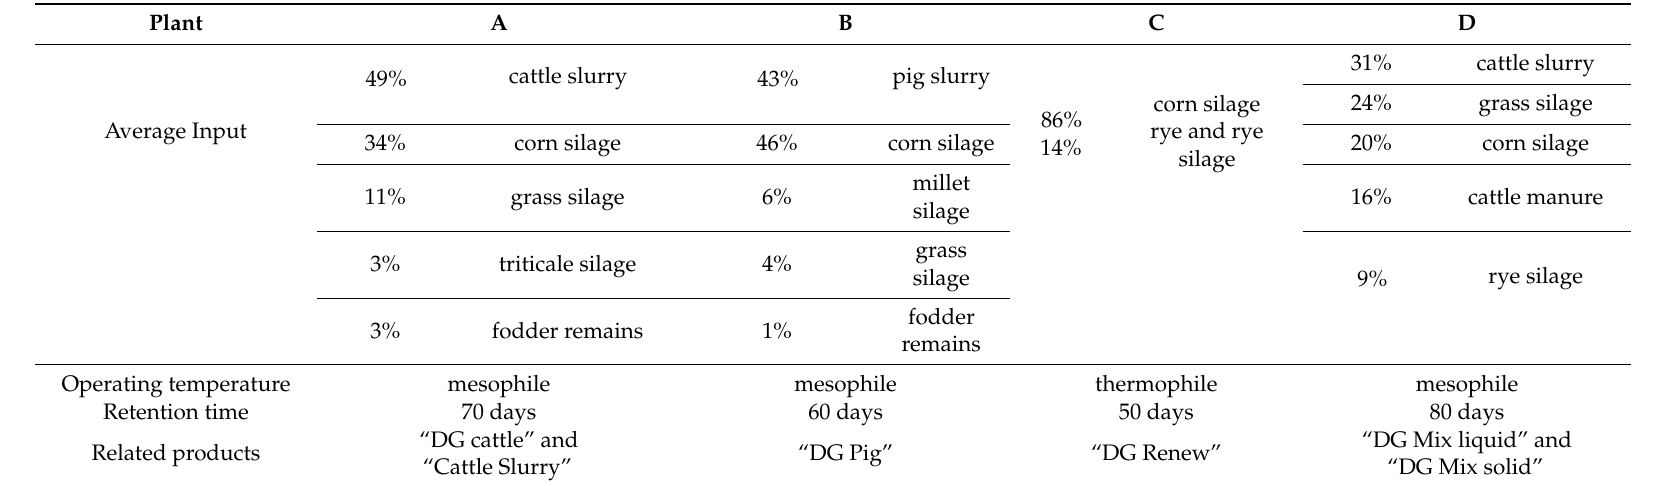
Table 1. Input materials and operating parameters of the four biogas plants included in the study (percent in fresh matter